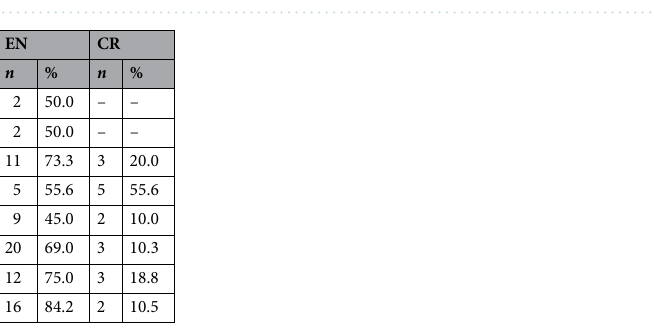
Figure 4. Native potential agroforestry plant species changing from a current assessed IUCN category or Not Evaluated (NE) to a threat category, Vulnerable (VU), Endangered (EN) and Critically Endangered (CR), based on different major uses due to climate change.